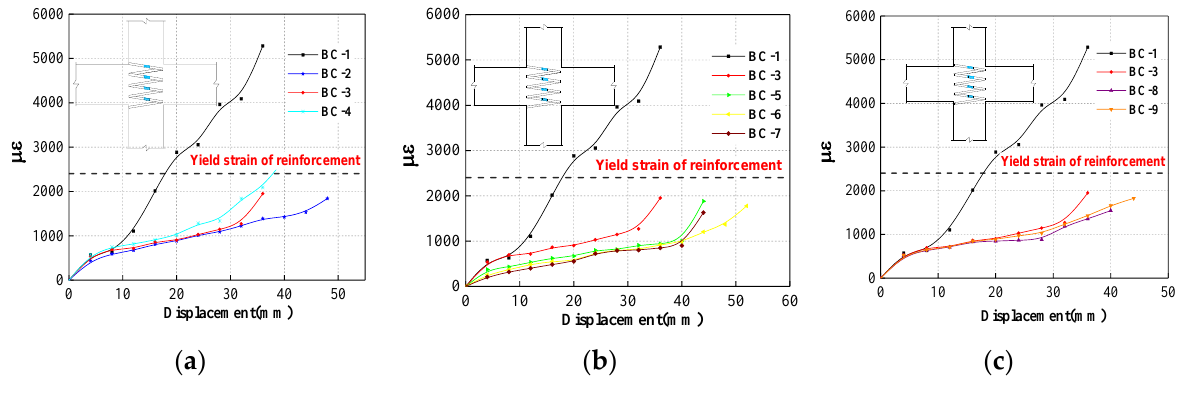
Figure 13. Maximum strains of GFRP hoops. ( a ) Stirrup ratio group; ( b ) Axial pressure ratio group; ( c ) Concrete strength group.